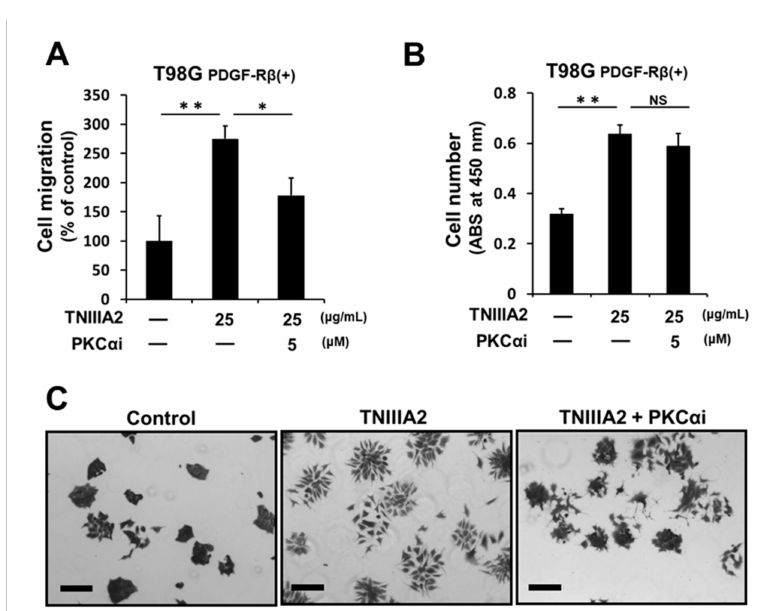
Figure 5. Potentiation of GBM cell scattering and migration by TNIIIA2 is dependent on PKC α activity. T98G cells were treated with TNIIIA2 in the absence or presence of PKC α inhibitor Go6976. ( A ) After 6 h, the migration rate was judged by a wound healing assay. ( B ) After 2 days, the number of viable cells was evaluated by WST-8 assay. Data represent the mean ± standard deviation of triplicate determinations, * p < 0.05, ** p < 0.01; NS not significant. ( C ) Scattering assay was performed as described in the Materials and Methods section. T98G cells were treated with or without Go6976 (5 µ M) for 1 h, and then cultured in the absence or presence of TNIIIA2 (25 µ g / mL) for 4 h. Scale bar, 200 µ